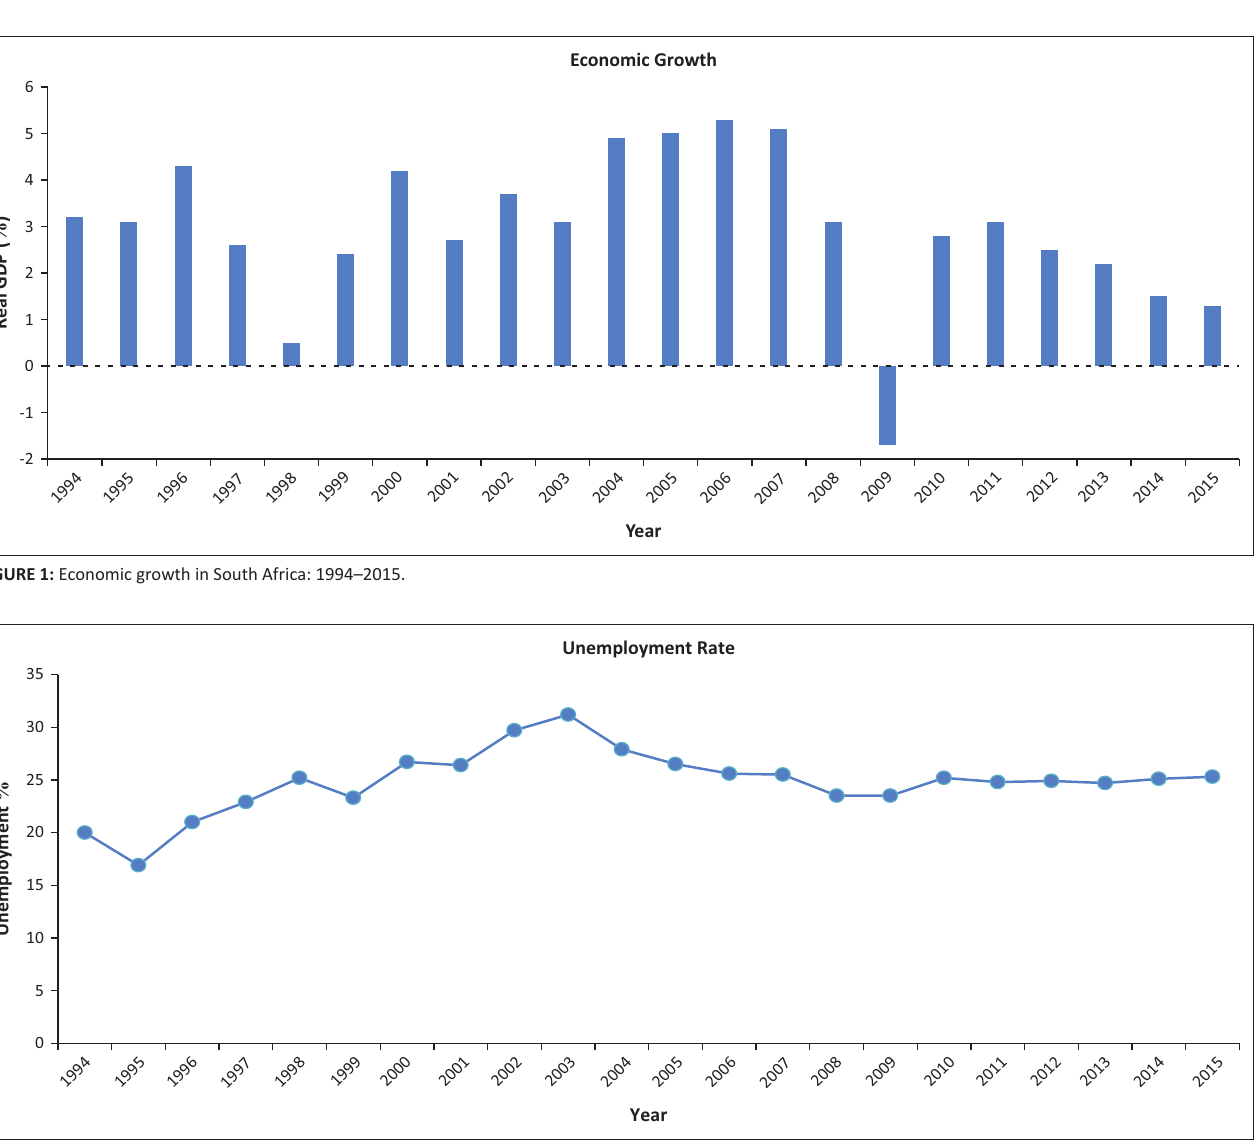
FIGURE 2: Unemployment rate in South Africa: